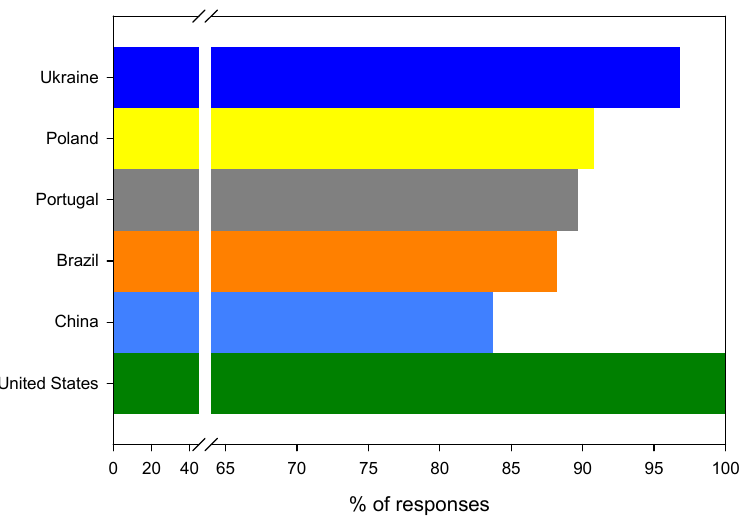
Figure 4. The distribution of positive answers to the question: Would you support replacing tradi- tional plastic food packaging with bioplastic packaging?